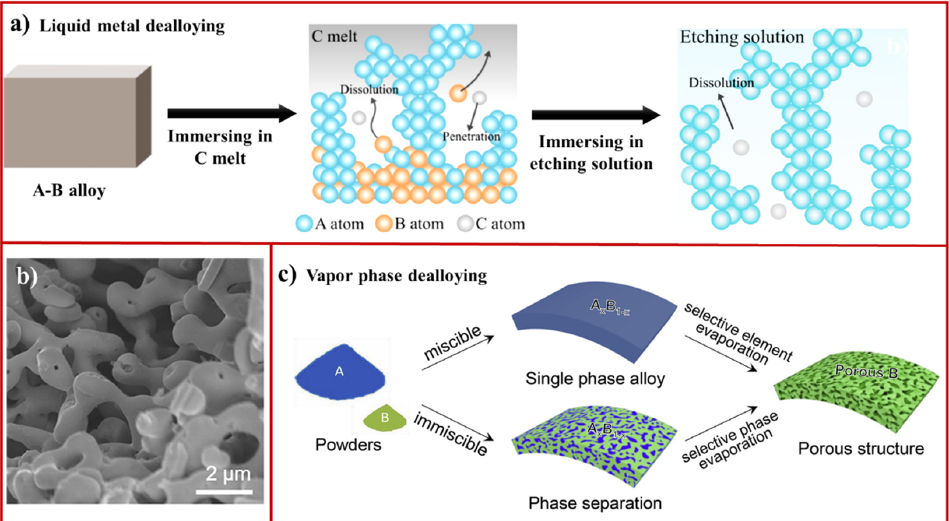
Figure 2 . ( a ) Schematic illustration showing liquid metal dealloying working principle (adapted from [38], Copyright 2021, Elsevier); ( b ) scanning electron microscopy (SEM) image of nanoporous TaTi after the removal of Cu from the TiTa-Cu composite (adapted from [76], Copyright 2020, Elsevier); ( c ) scheme displays the principle of vapor phase dealloying (adapted from [77], Copyright 2019, Elsevier).